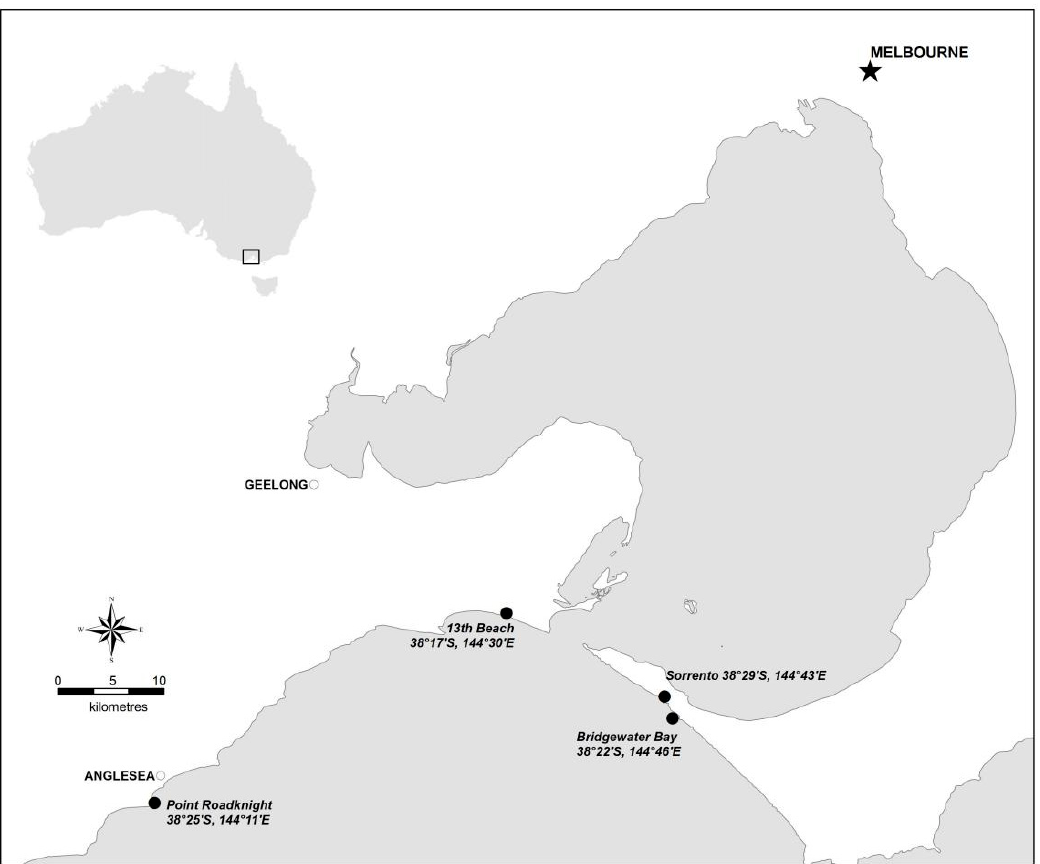
Figure 1. Map showing study sites (black filled circles) including latitudes and longitudes. Bridgewater Bay and 13th Beach are experiment sites, Sorrento and Point Roadknight are background sites. All sites on the coast of the Southern Ocean, Bass Strait is directly south (not shown).